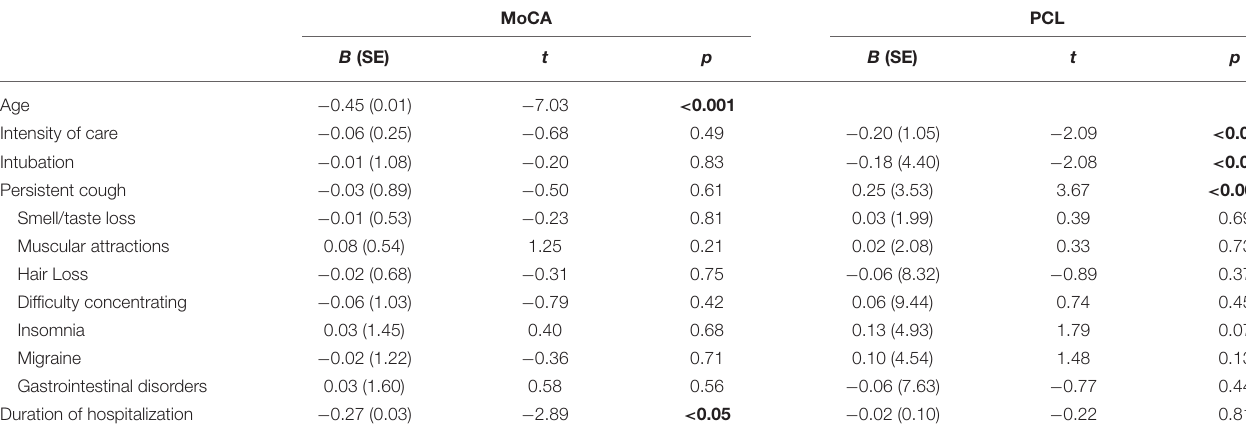
TABLE 2 | Shows linear regression models for the whole sample.